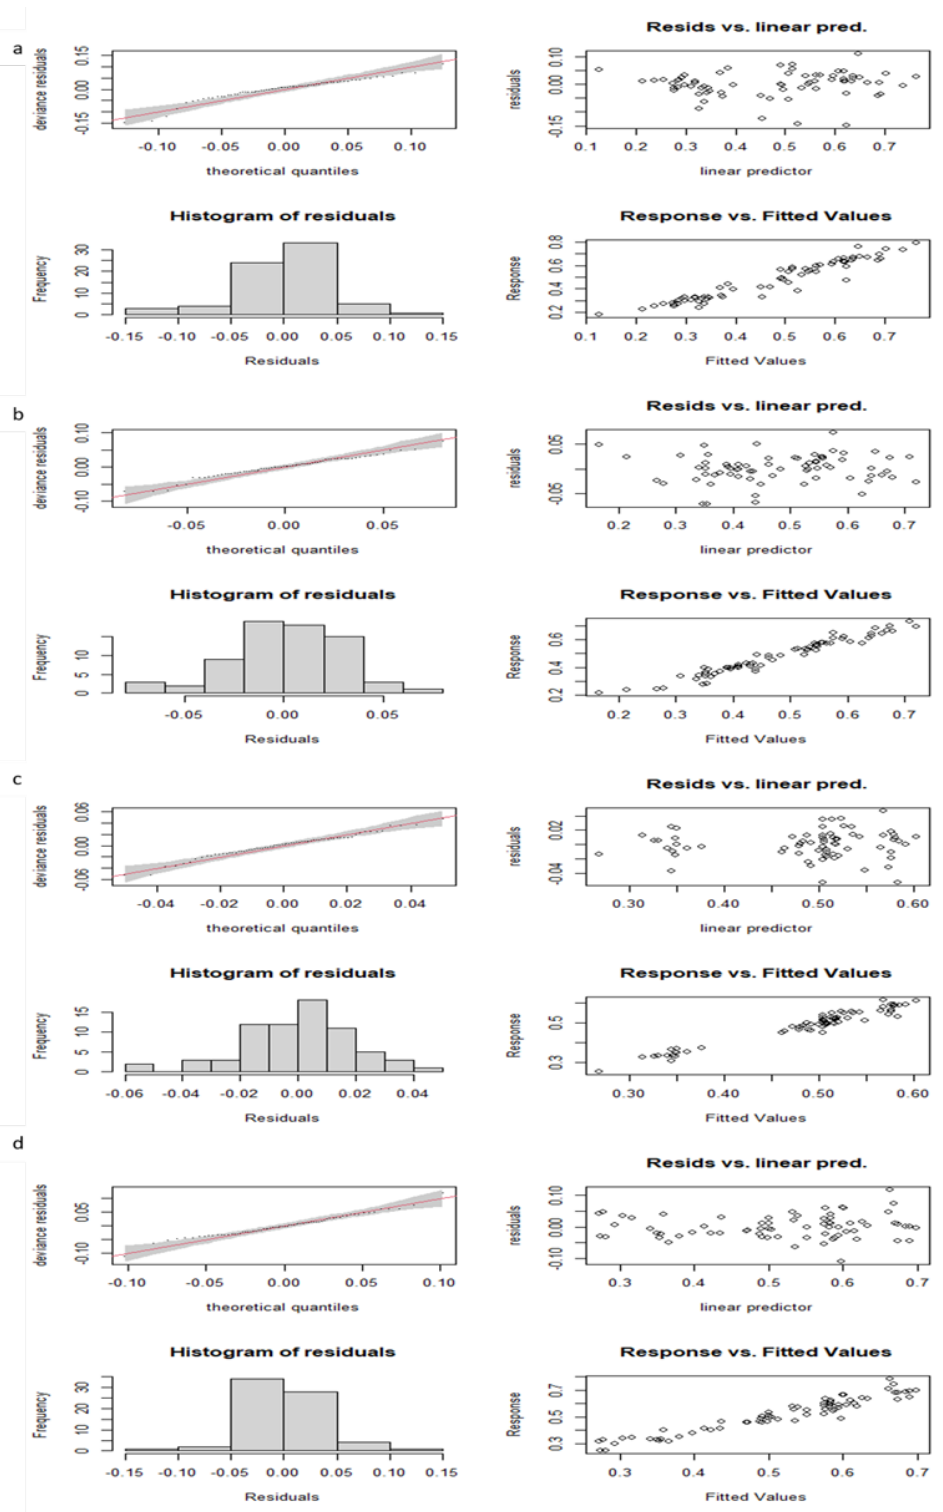
Figure A5. Diagnostic plots of the alternative GAM models, using the beginning-of-the-season values of ungulate census, adjusted to the production (peak NDVI) of the four main vegetation types consumed by wild and domestic ungulates at the study area (Doñana National Park). Model for saltmarsh ( a ), bulrush marsh ( b ), shrubland ( c ), and grassland ( d ).